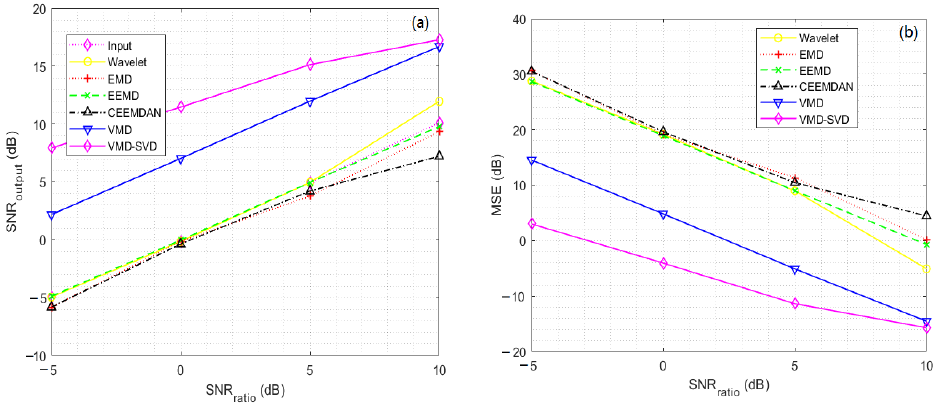
Figure 8. Denoising performance of noisy Block signals with different SNRs. ( a ) SNRs after noise reduction by various methods with different noise ratios. ( b ) MSEs after noise reduction by various methods with different noise ratios. Table 1. The SNR and MSE after noise reduction by five methods when superimposed with noise with different SNRs